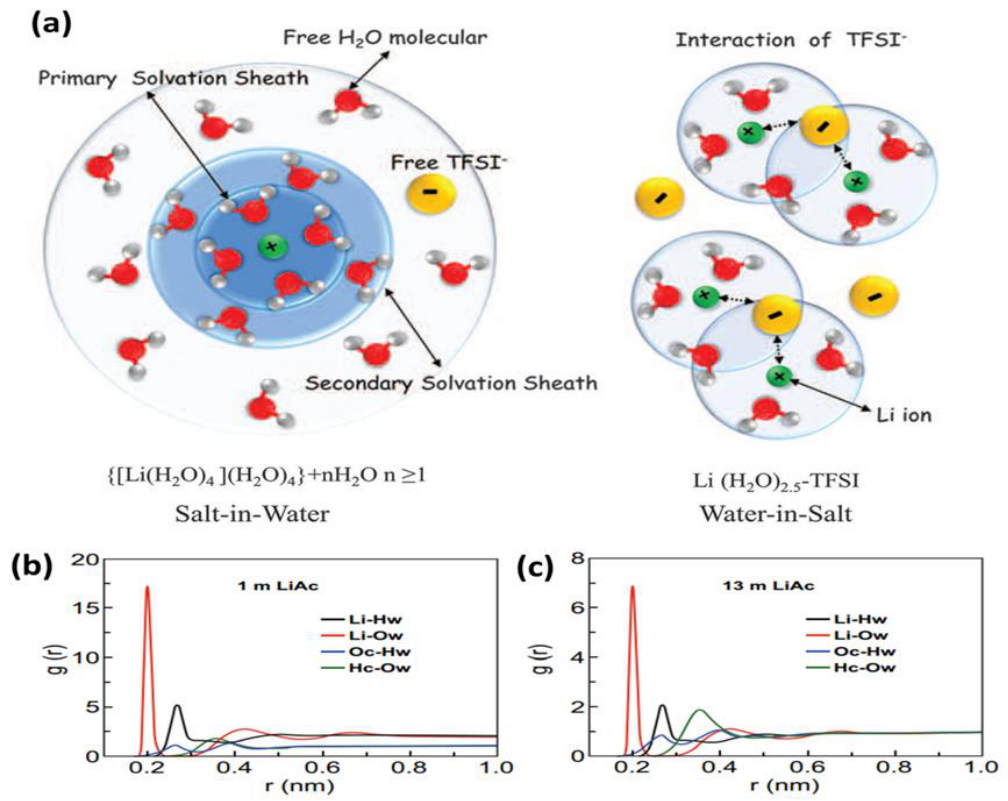
Figure 3. ( a ) A pictorial comparison of the structures of salt - in - water and WIS electrolytes. Re- printed with the permission of [72]. RDF curves of ( b ) 1 m LiAc and ( c ) 13 m LiAc electrolytes ob- tained using molecular dynamics (MD) simulation. Reprinted with the permission of